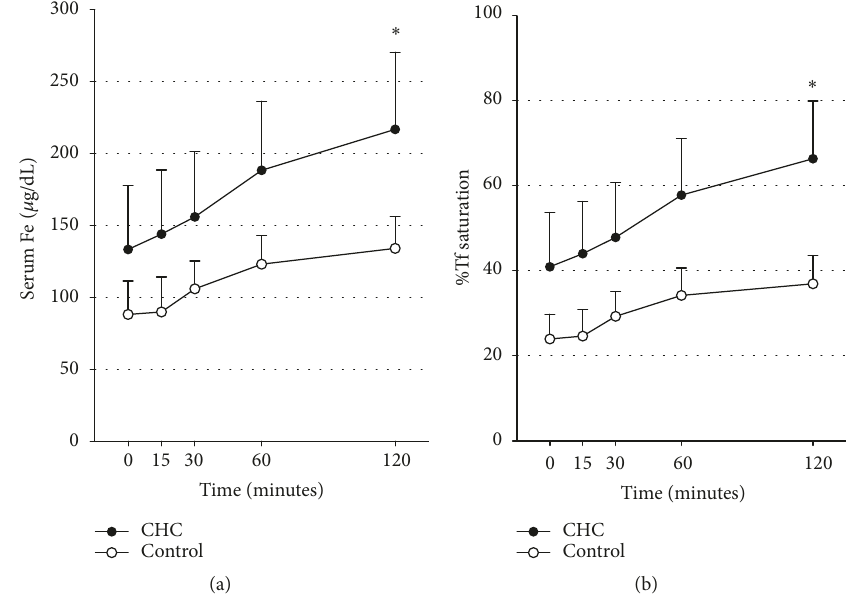
Figure 1: Serial changes in sFe (a) and Tf sat (b) after administration of sodium ferrous citrate. Closed circles indicate patients with CHC; open circles indicate controls. Compared to the control group, sFe and Tf sat were significantly increased in the patients with CHC (repeated- measures ANOVA. ∗ 𝑃 < 0.001). These data show that iron absorption from the GI tract was significantly increased in the CHC patients.